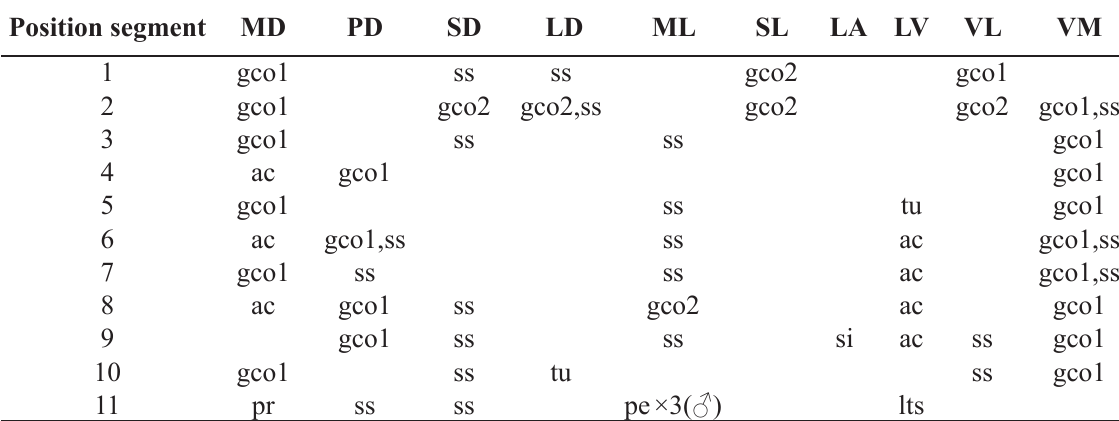
Table 17. Summary of nature and location of sensory spots, glandular cell outlets, tubes and spines arranged by series in Echinoderes legolasi sp.